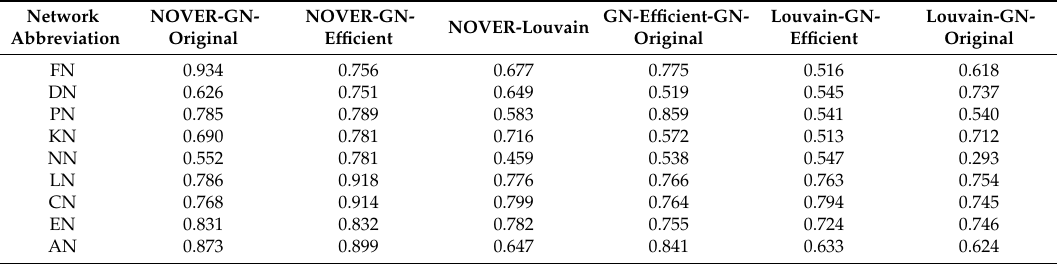
Figure 13. Illustration of the mutual comparison of the community detection algorithms on real-world Network graphs based on NMI scores. Table 1. A Mutual comparison of the community detection algorithms based on NMI scores.